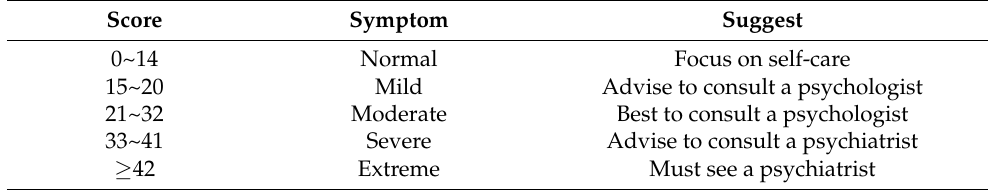
Table 2. Score grading and recommendations for comprehensive facial emotion recognition.